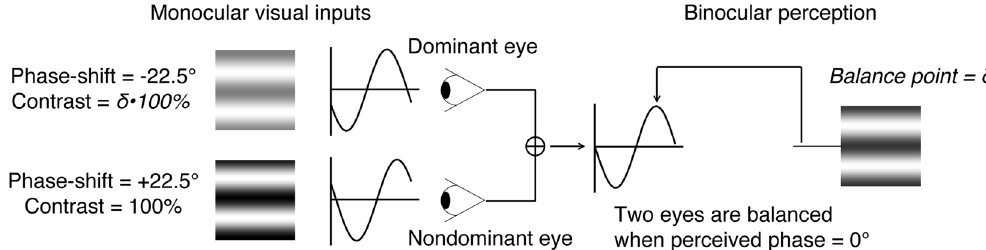
Figure 1. Illustration of the binocular phase combination paradigm. Two horizontal sine-wave gratings with equal and opposite phase-shifts of 22.5° (relative to the center of the screen) were dichoptically presented to the two eyes through the polarized glasses. The perceived phase of the cyclopean grating depends on the contribution of the two eyes in binocular phase combination. Sensory eye dominance is quantified by the interocular contrast difference that is needed to achieve a 0-degree of perceived phase, i.e., the balance point, where the two eyes are balanced in binocular phase combination.